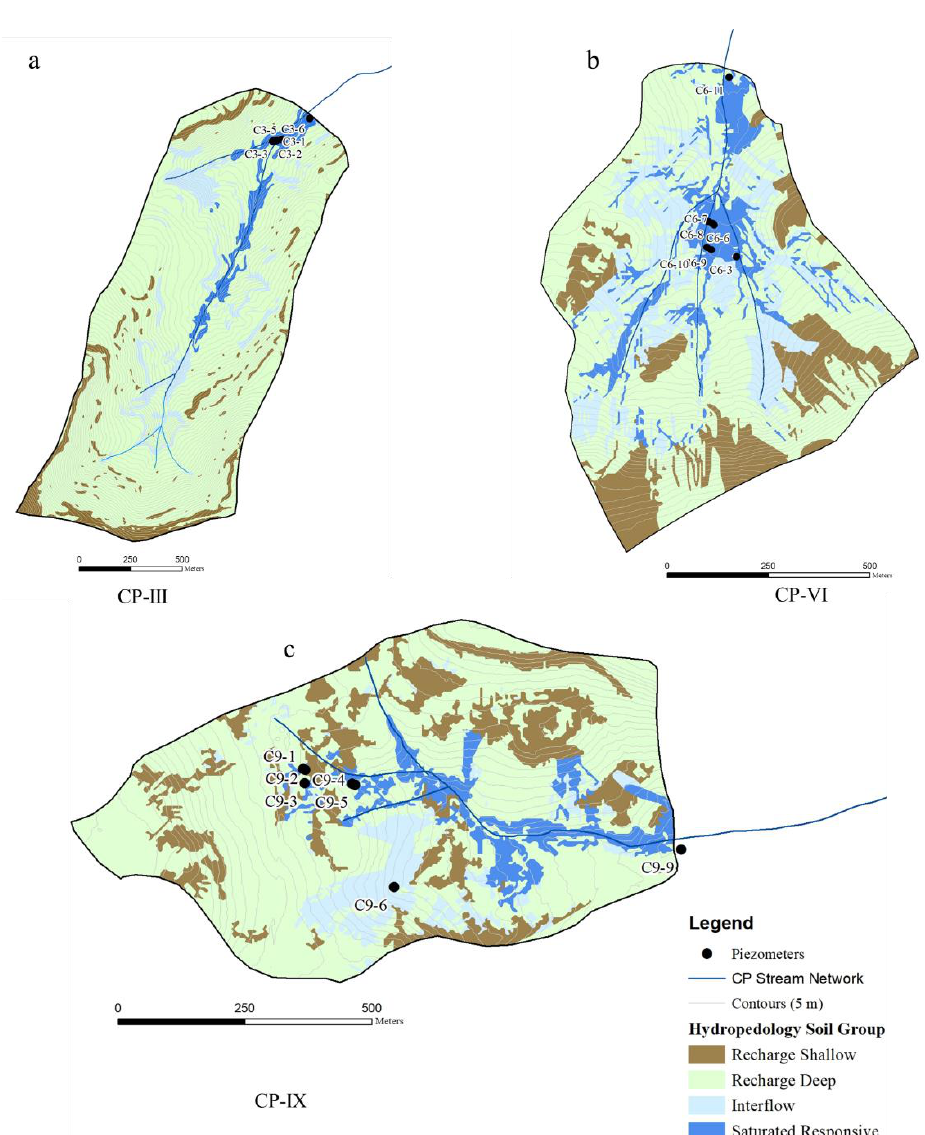
Figure 2. Location of the piezometers in relation to the hydropedological soil group in ( a ) CP-III, ( b ) CP-VI, and ( c ) CP-IX. Table 3. Percentage of the catchment area covered by each hydropedological soil group.